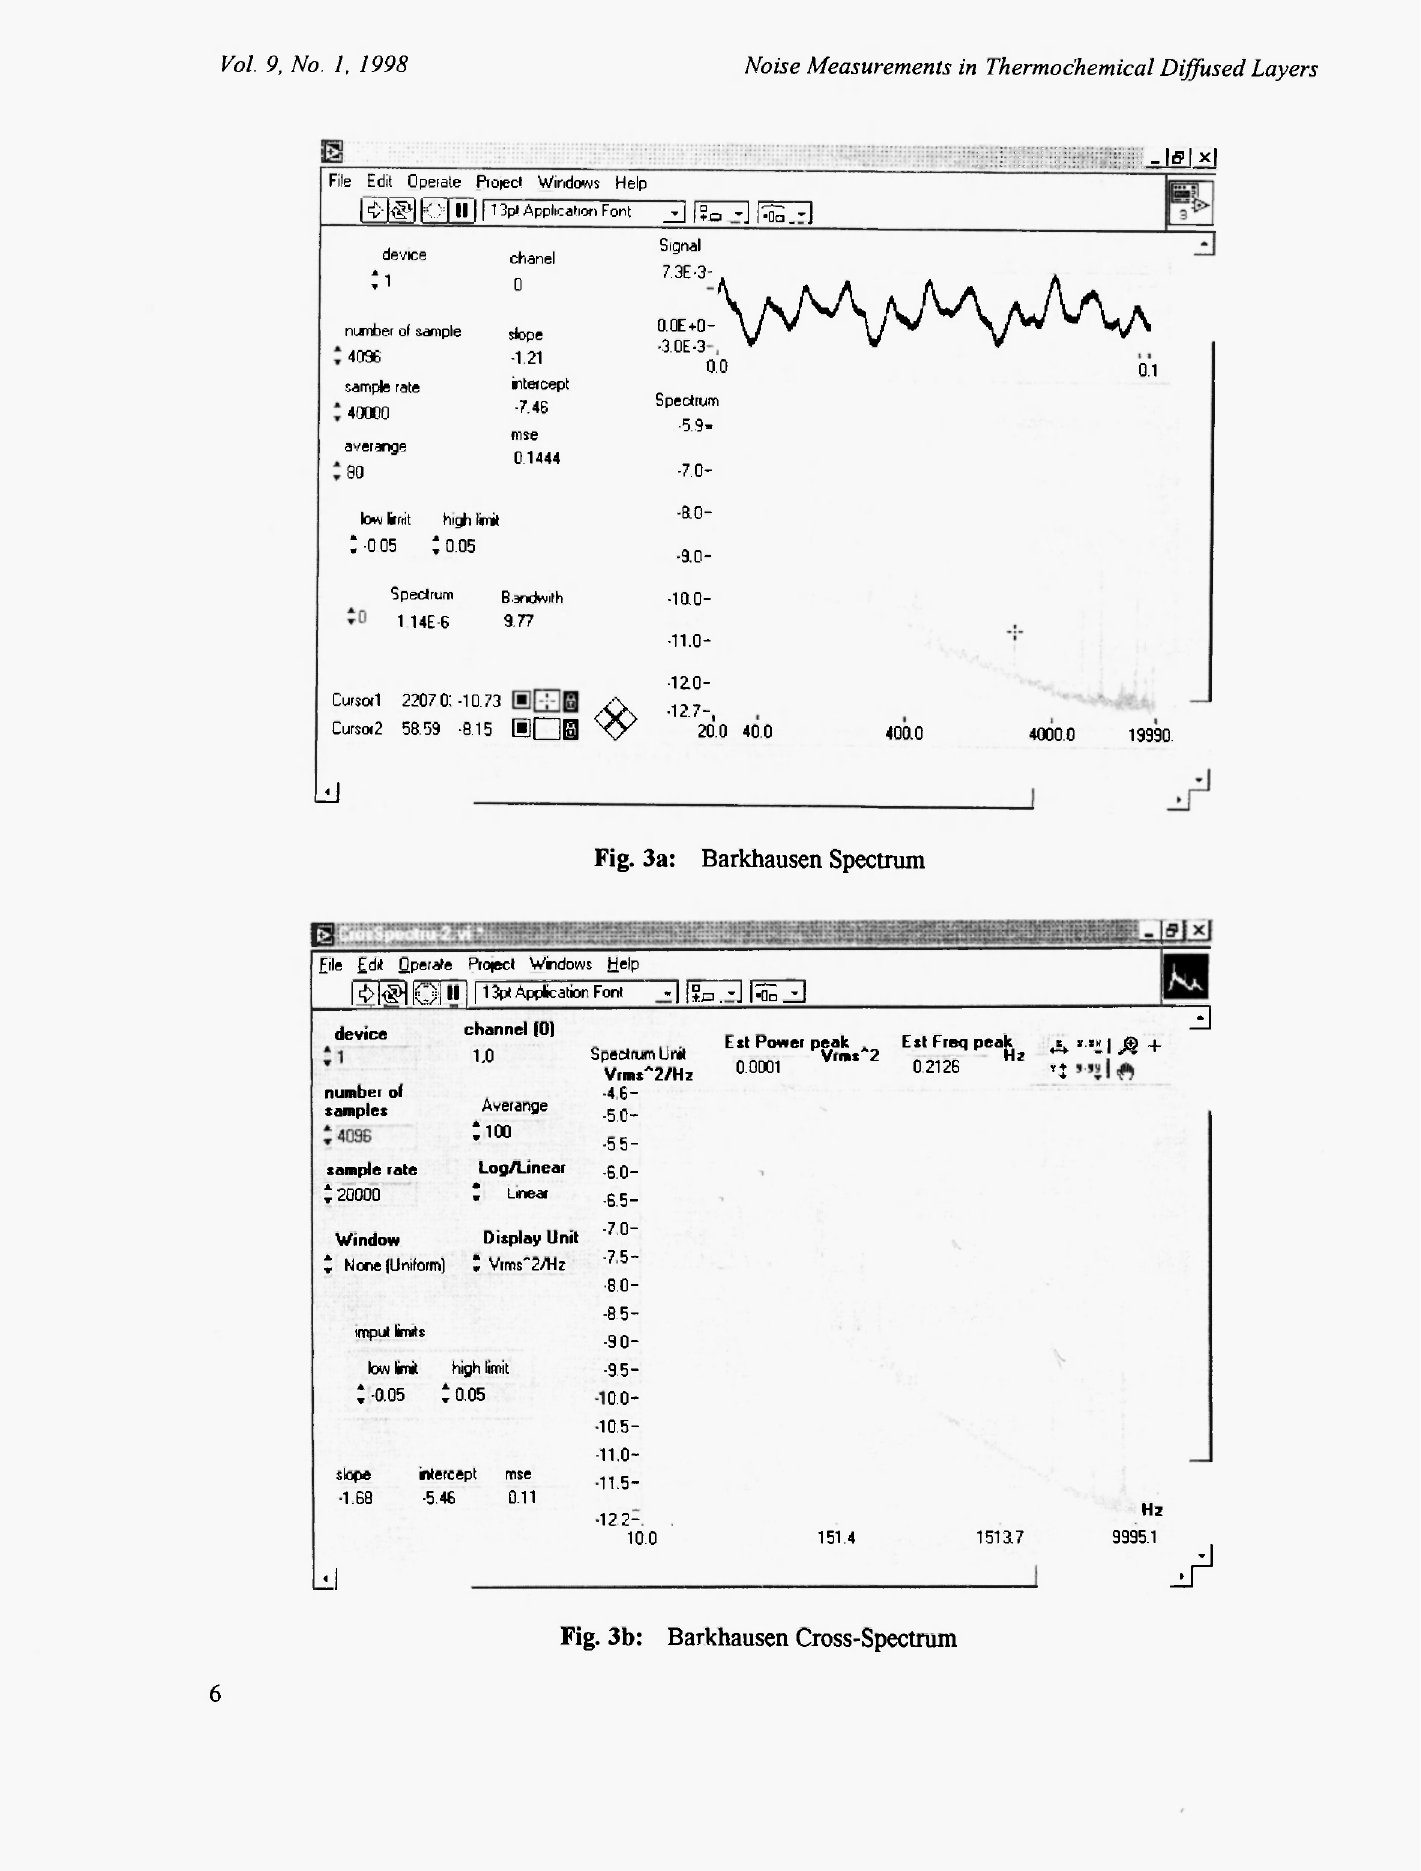
Fig. 3b: Barkhausen